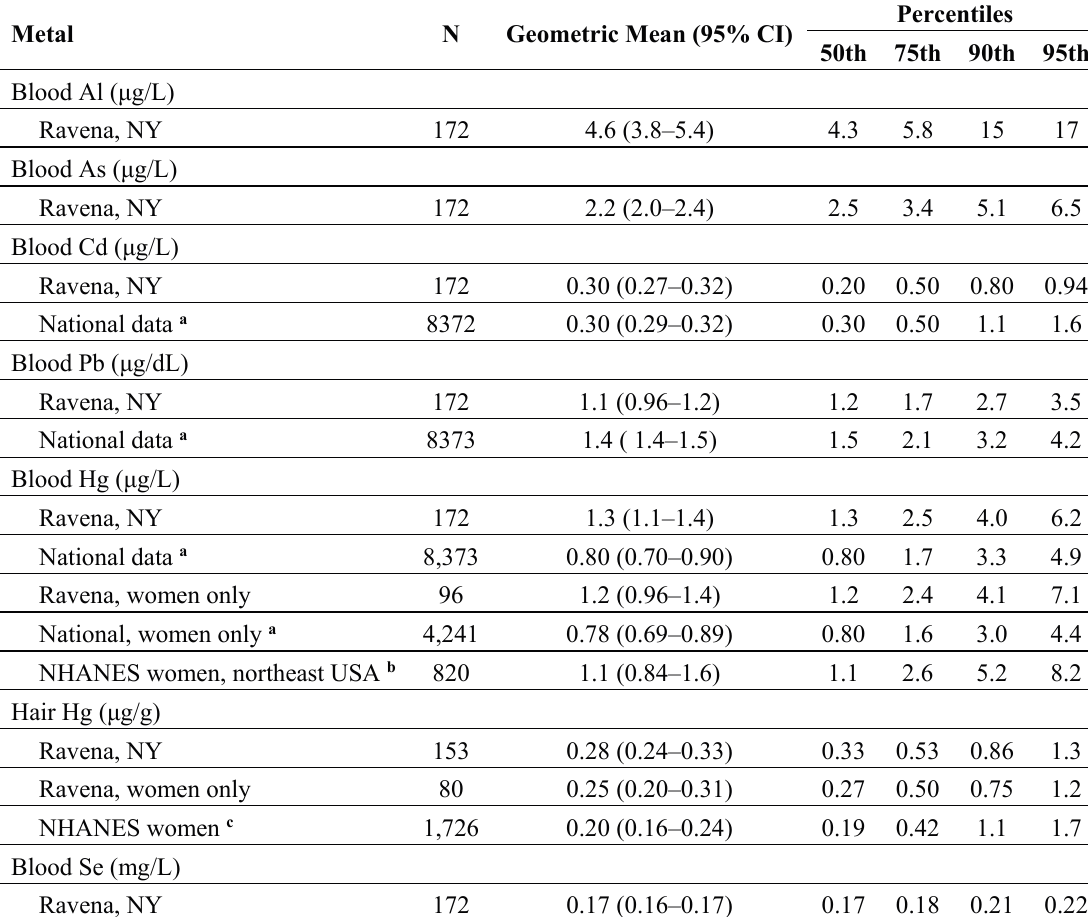
Table 2. Levels of Al, As, Cd, Pb, Hg and Se in blood and Hg in hair, compared to NHANES national data.